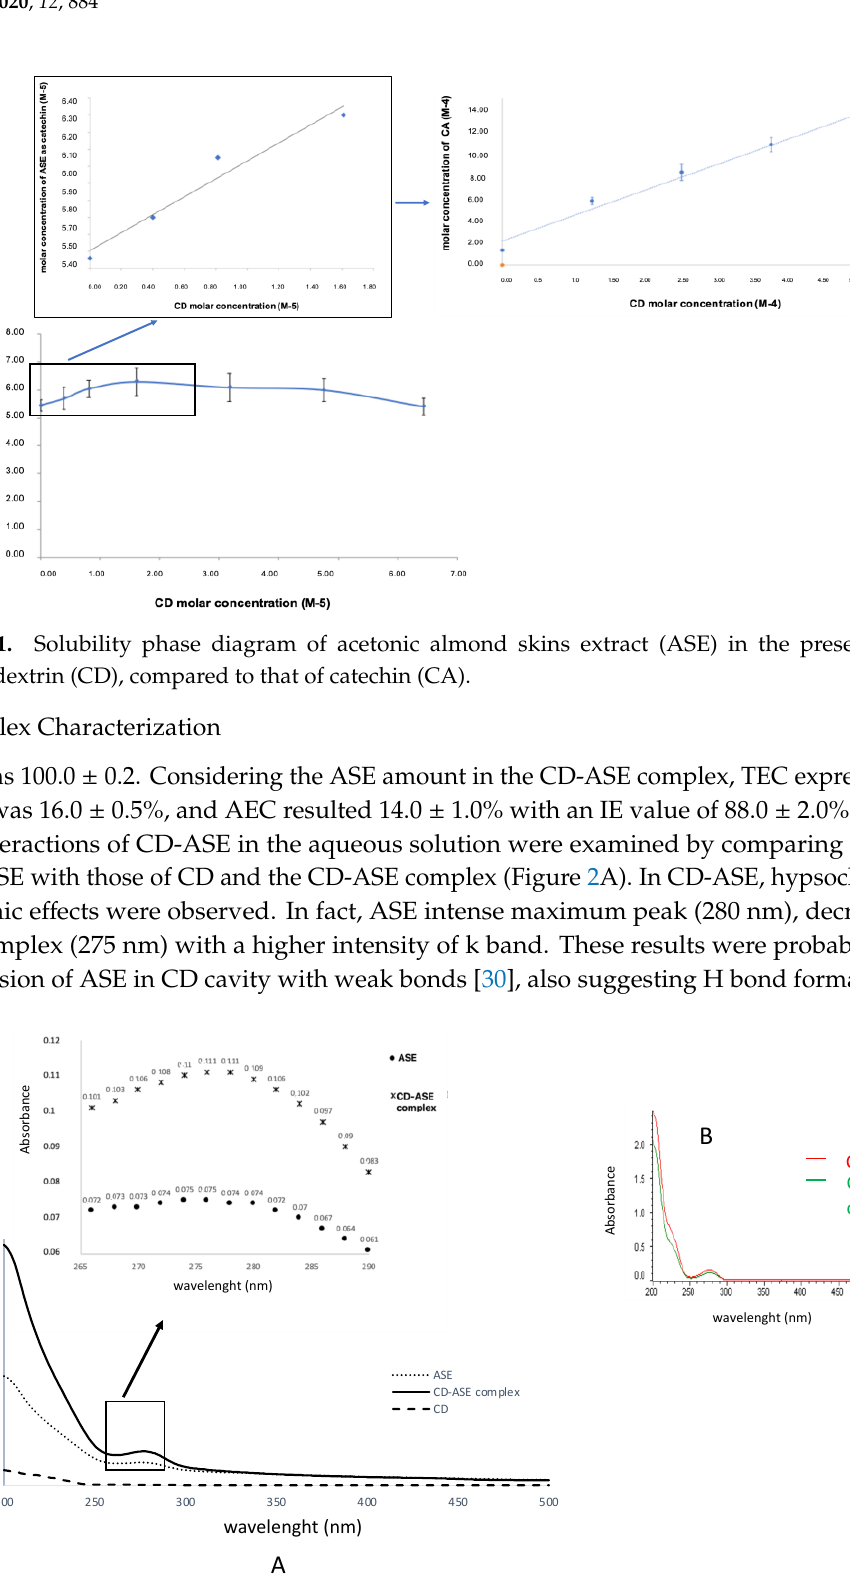
Figure 2. UV spectra analyses of: ( A ) ASE-CD complex in comparison with ASE and CD pure materials; ( B ) CD-CA complex in comparison with CA pure.